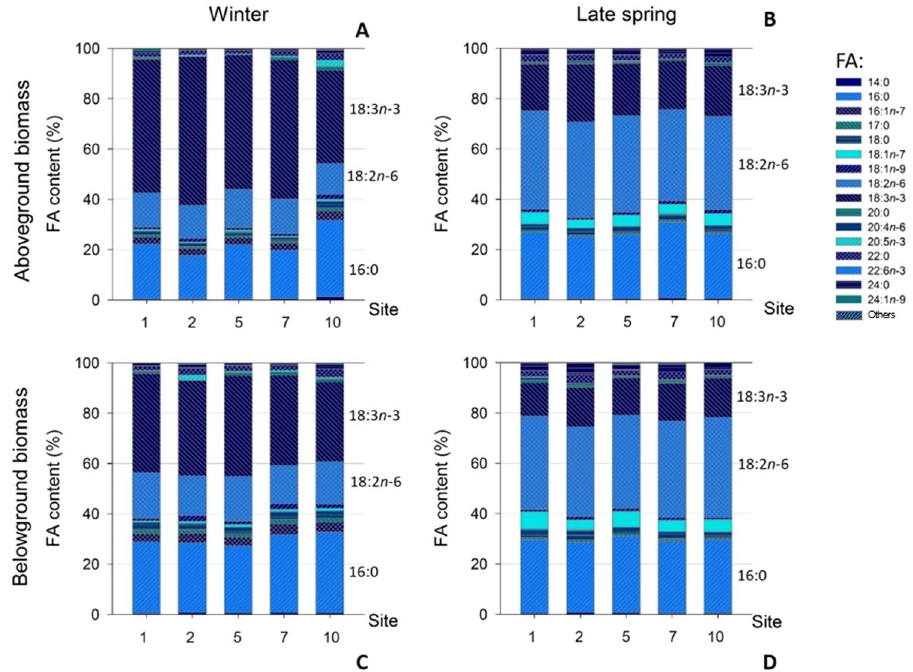
Figure 8. Individual esterified fatty acid (FA) relative content (%) in Z . noltei aboveground biomass in winter ( A ) and late spring ( B ) along Mira channel. FA relative content in belowground biomass are shown also for winter ( C ) and late spring ( D ) (mean values, N = 3). “Others” refer to the sum of FA 10:0, 11:0, 12:0, 13:0, 14:1, 15:0, 15:1, 16:1 n -9, 19:3, 20:1, 20:2, 20:3 n -3, 20:3 n -6 and